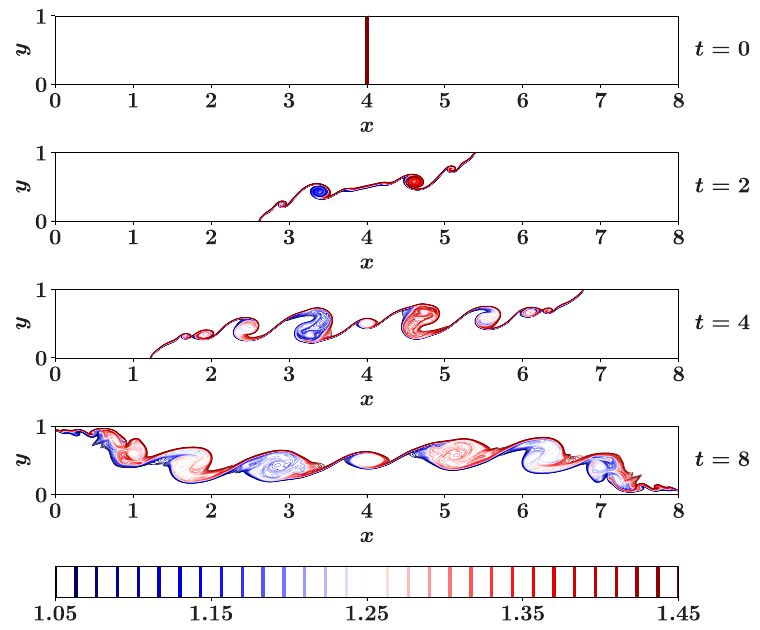
Fig 5. Temperature field at different time instances for 2D Boussinesq problem using 4096 × 512 grid and Δ t =